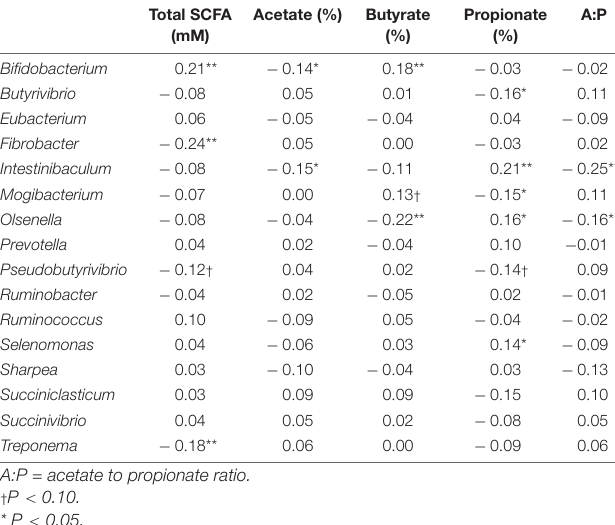
TABLE 3 | Correlation coefficients amongst rumen bacterial genera with rumen fermentation characteristics. Total SCFA Acetate (%) Butyrate Propionate (mM) (%) (%)